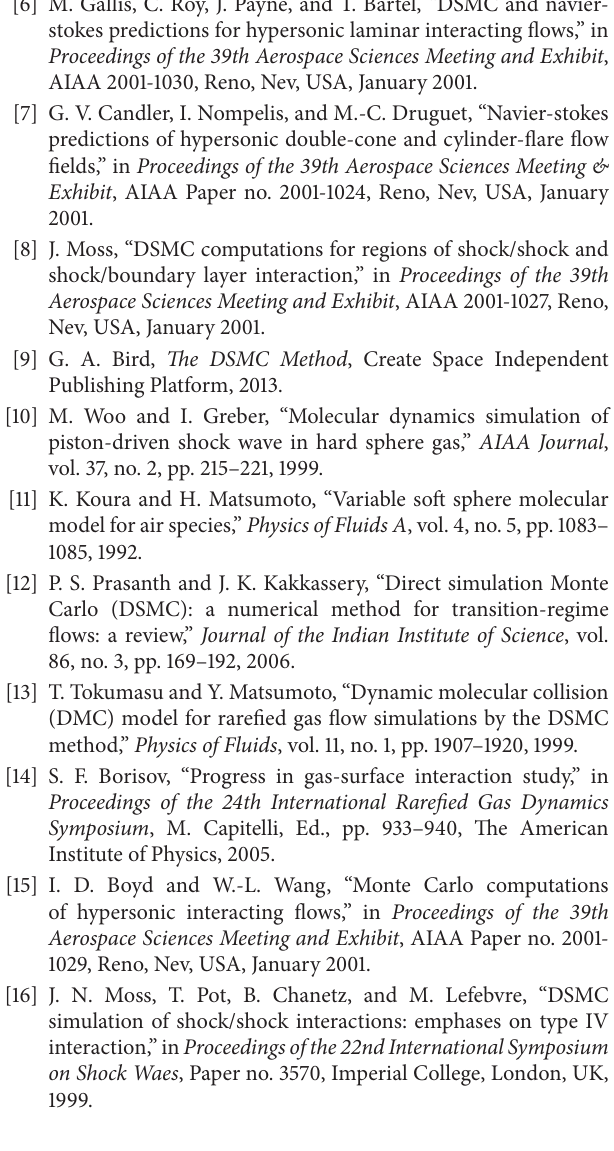
Table 6: Comparisons of calculations (( Value The scale of interaction region Run Kn (error in compared with measured data %) VHS 9.05 × 10 −5